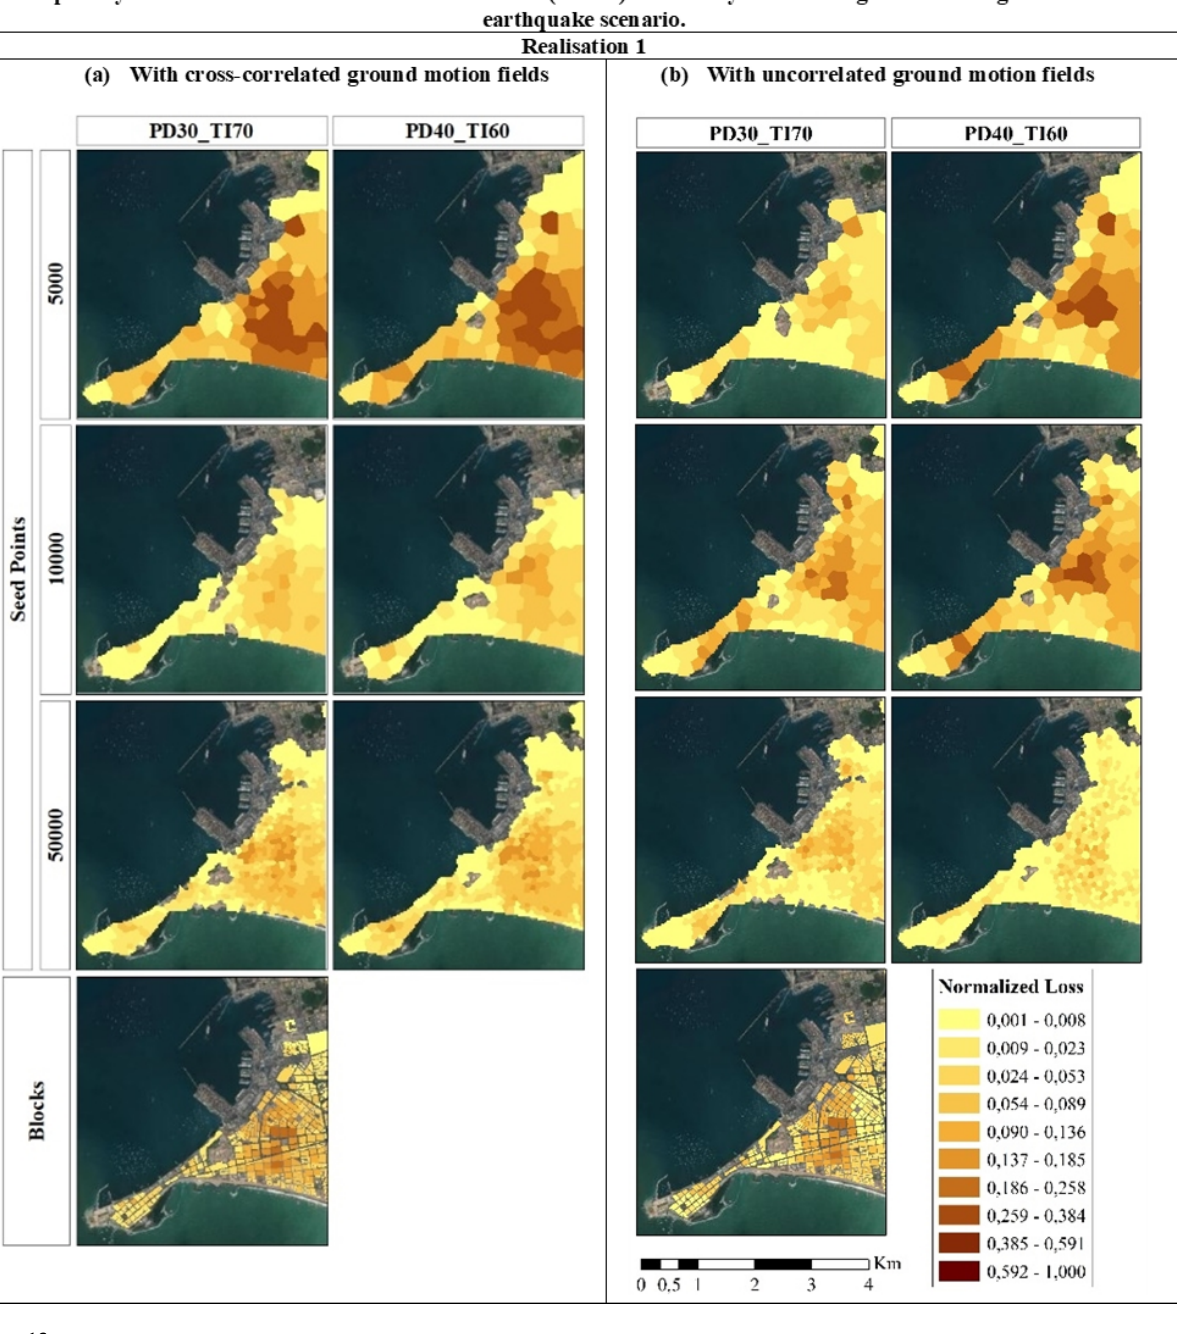
the two CVT models with the largest number of geo-cells (50 000) show the closest similarity to the block model (nor- malised ratio ∼ 1). However, for all the CVT models, this ratio dramatically drops for scenarios with lower magnitudes (8.5, 8.6, and 8.7), which can probably be explained by a smaller tsunami footprint and lower IM spatial